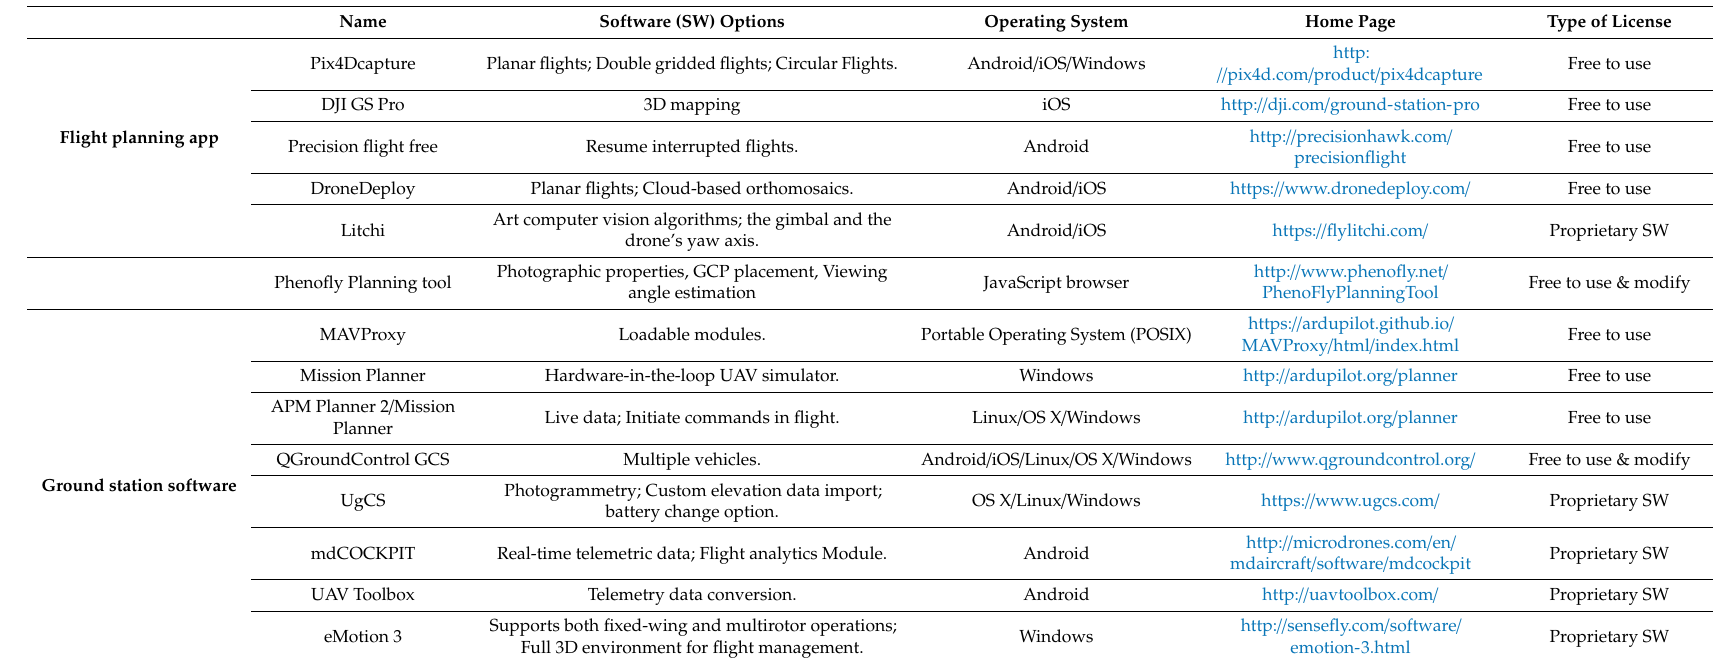
Table 3. List of the UAS mission planning software and their main